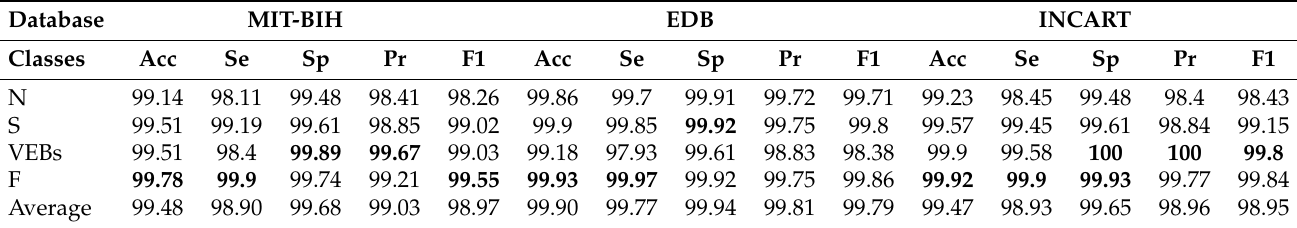
Table 4. The performance of the MPA-SVM classifier on all the databases’ classes.